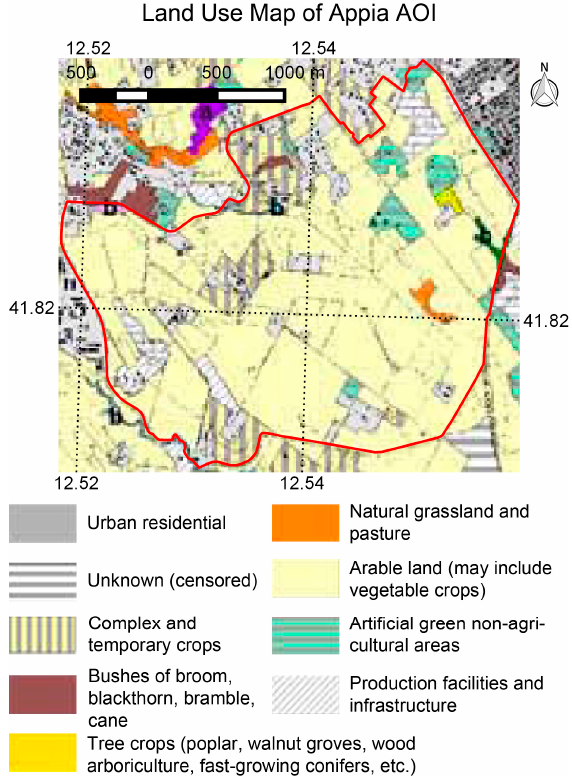
Figure 23. Land use map of Appia AOI (shown in red polygon), last updated in 2007, courtesy of the Comune di Roma [64].